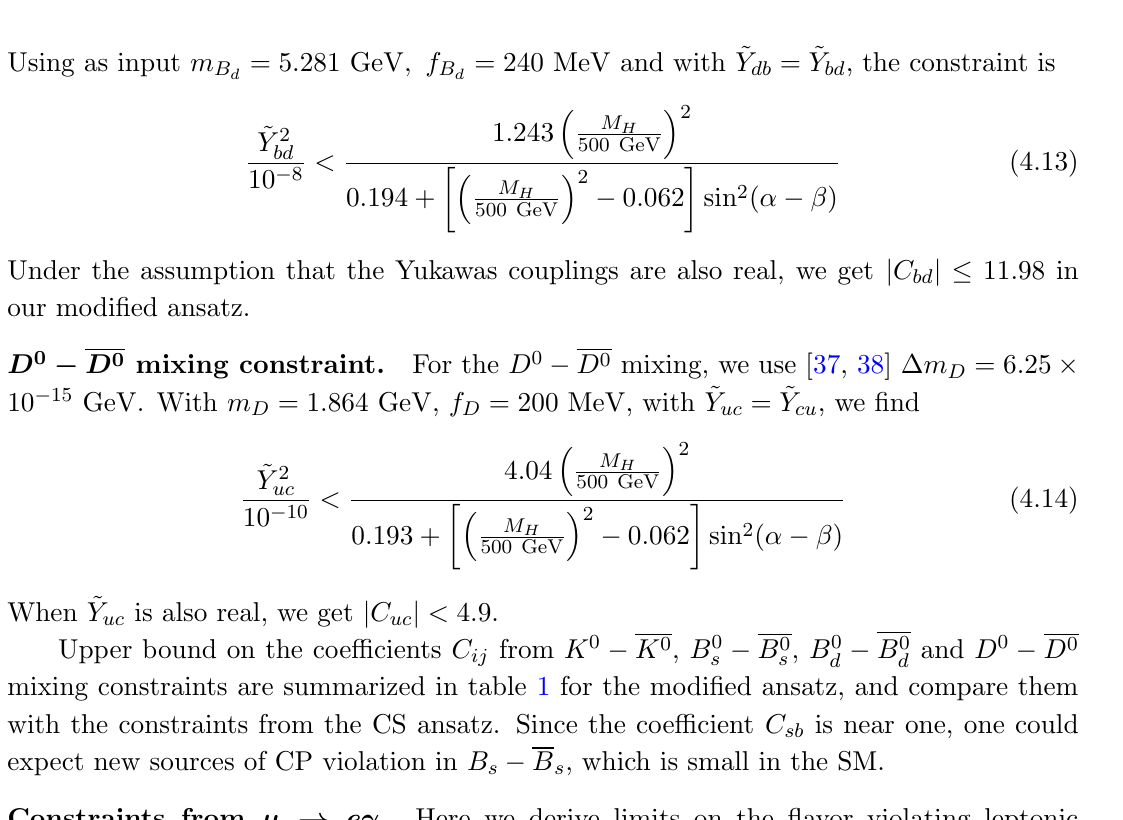
Table 1 . Upper bounds on the coe(cid:14)cients C ij from K 0 (cid:0) K 0 , B 0 mixing constraints. Here we have set Y ij = Y ji , assumed the couplings to be real, and took M H = M A = 500